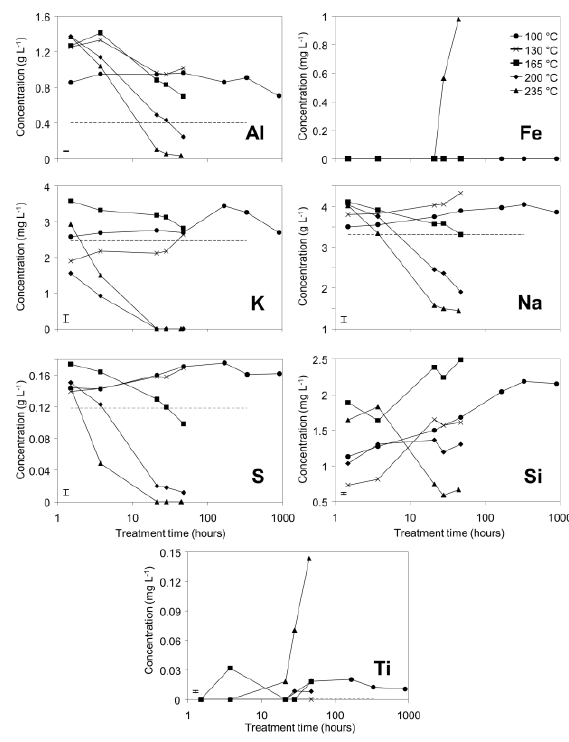
Figure 2. Concentrations of selected elements (mg or g·L −1 ) in supernatant from bauxite residue after treatment in pressure vessels. Dashed lines indicate concentrations at t = 0. Where no dashed line is visible, concentrations at t = 0 were below detection limits. Note that treatment time ( X axis) is graphed on a logarithmic scale. Error bars indicate 95% confidence interval for the mean of the 100 °C treatment at 909